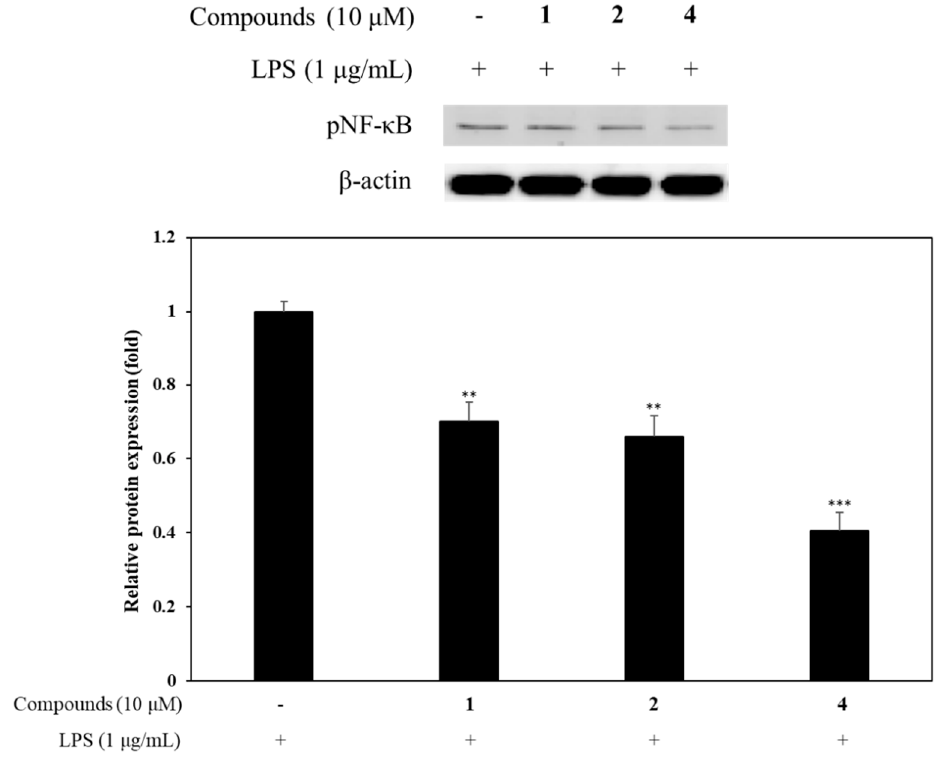
Figure 5. Effect of limonoids on NF- κ B activation. RAW 264.7 cells were cultured in the presence of compounds 1 , 2 , and 4 (10 µ M) for one hour and stimulated with LPS (1 µ g / mL) for one hour. The levels of pNF- κ B were detected by Western blot analysis. Relative density was calculated as the ratio of the expression levels of each protein with β -actin. The data are expressed as the mean ± SD ( n = 3). ** p < 0.01 and *** p < 0.001, compared with LPS-stimulated group.